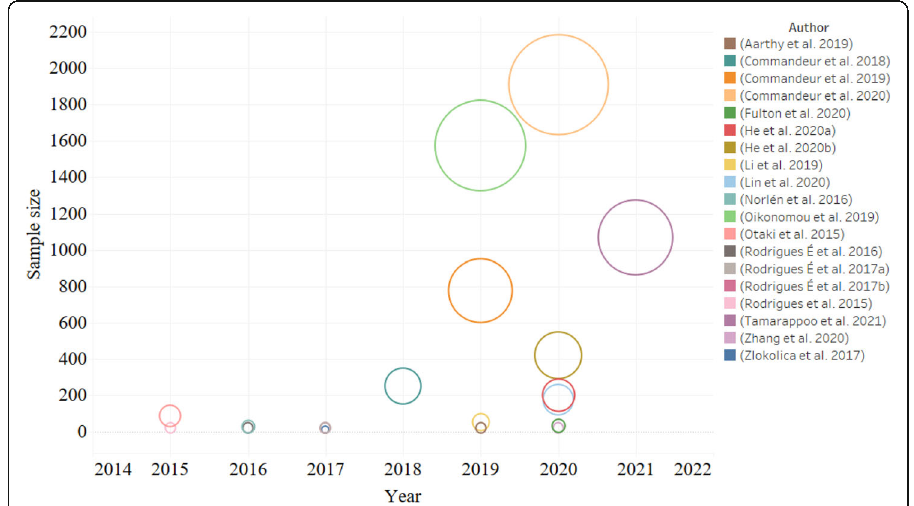
Fig. 2 Sample size of the studies included in the systematic review by year of publication. The area of circle represents sample